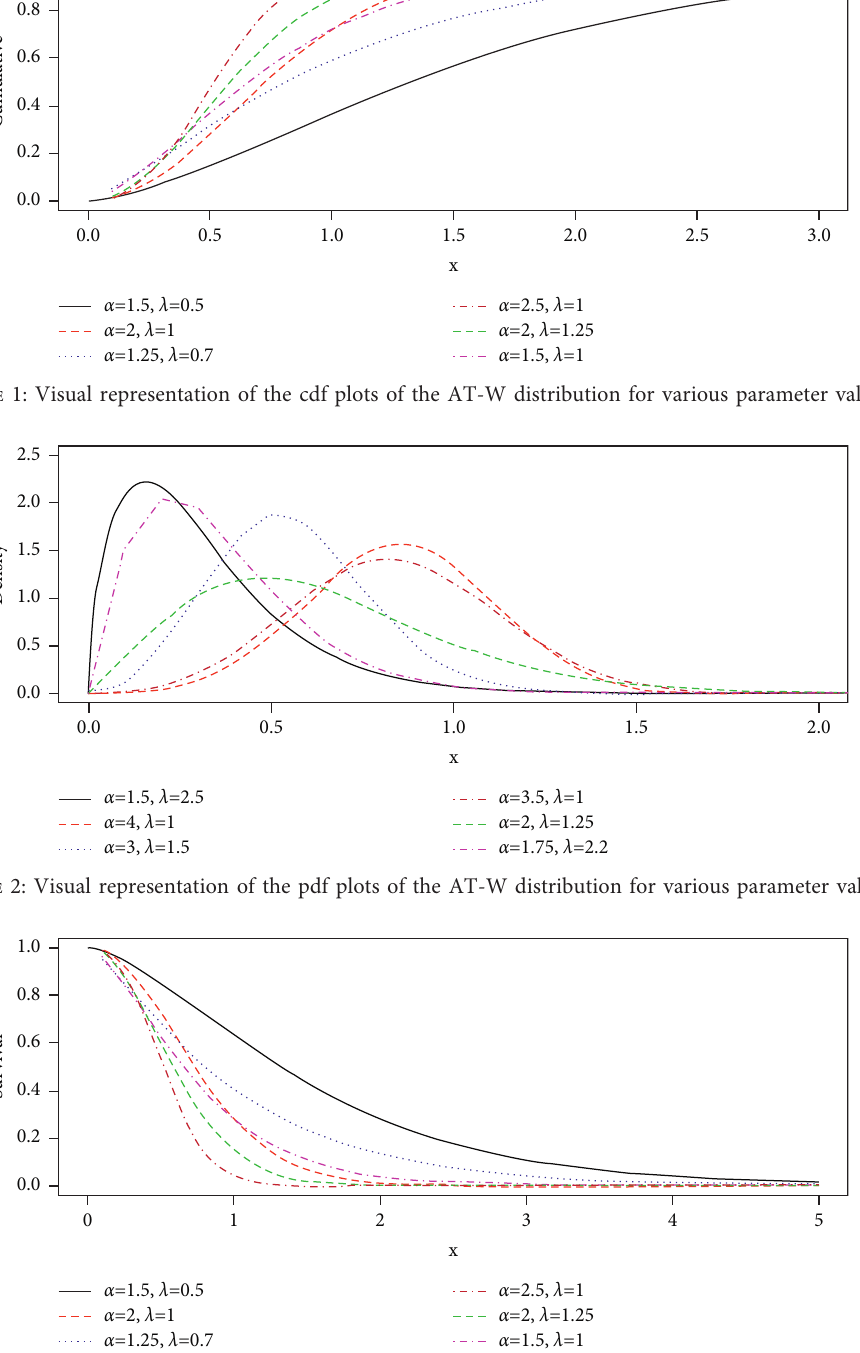
Figure 3: Visual representation of the cdf plots of the AT-W distribution for various parameter